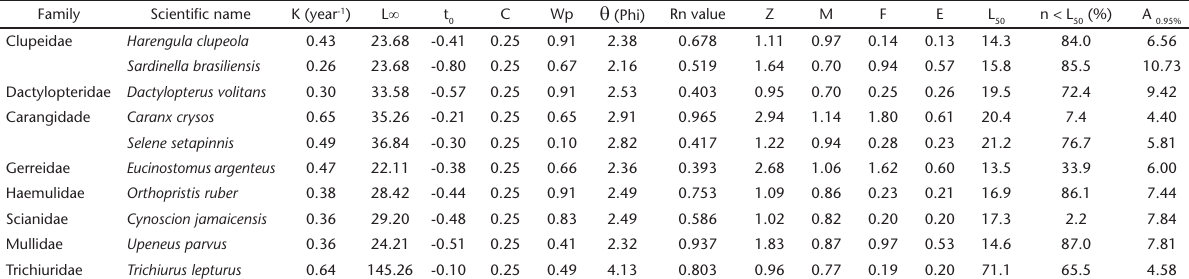
Table 2. Values of constant growth rate (k; year -1 ), asymptotic total length (L ; cm), nominal age at which fish length is considered zero ∞ (t ; year), C (seasonal oscillation amplitude; Cº), Wp (winter point); growth performance index ( θ ; Phi); instantaneous total mortality (Z), 0 natural mortality (M), fishing mortality (F), exploitation ratio (E), length of first sexual maturity (L ), proportion of individuals below the 50 length of first sexual maturity (n < L ;%) and longevity (A ; years) by small scale fisheries in Itaipu costal 50 0.95%